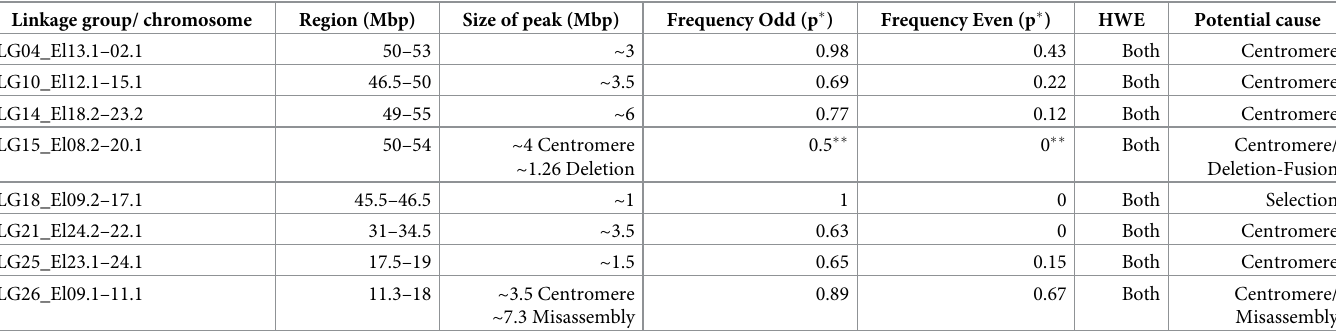
Table 1. Largest Fst peaks between odd and even-year lineages. Linkage group/